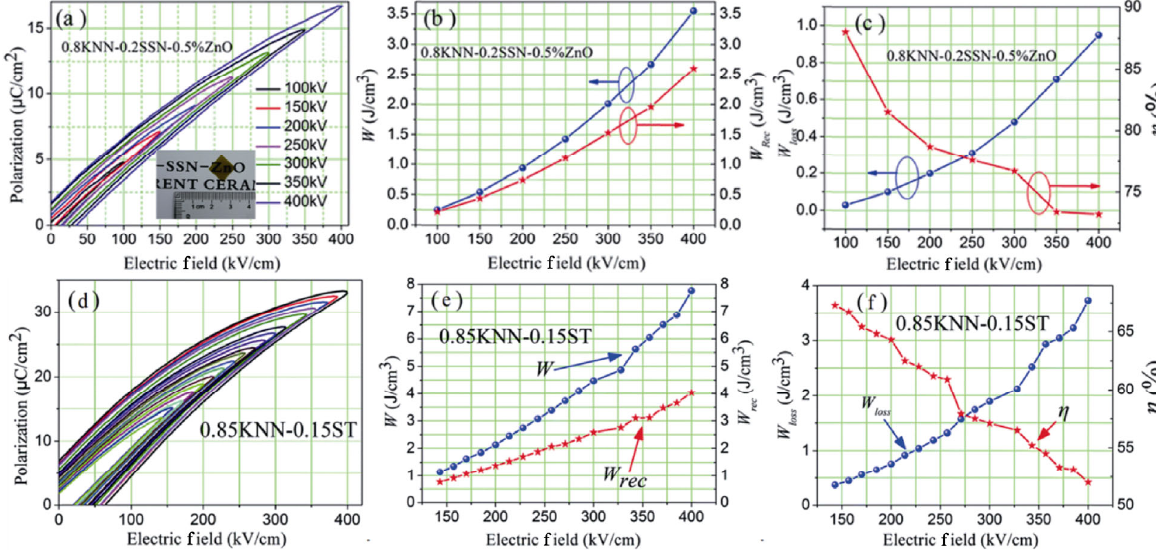
Fig. 8 P – E loops and energy-storage properties at room temperature of (a–c) 0.8KNN–0.2SSN–0.5%ZnO and (d–f) 0.85KNN– 0.15ST. Reproduced with permission from Refs. [54,55], © The Royal Society of Chemistry